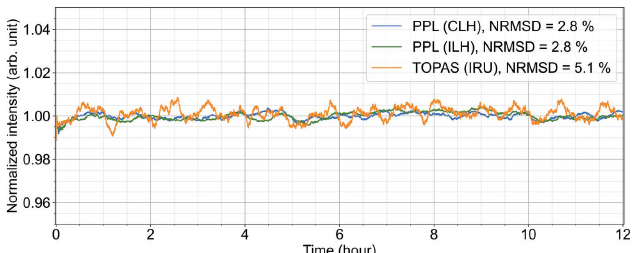
Figure 7 Intensity stability of the TOPAS output measured at IRU over 12 h with the output beam set at a wavelength of 640 nm. The three lines show the 10 min moving average of intensity stability of the PP laser in the CLH, the ILH and the OPA output at IRU. Here the intensity is normalized to the mean intensity of each measurement.